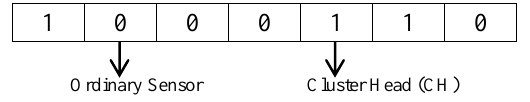
Figure 1. A schematic view of a chromosome with 7 genes.